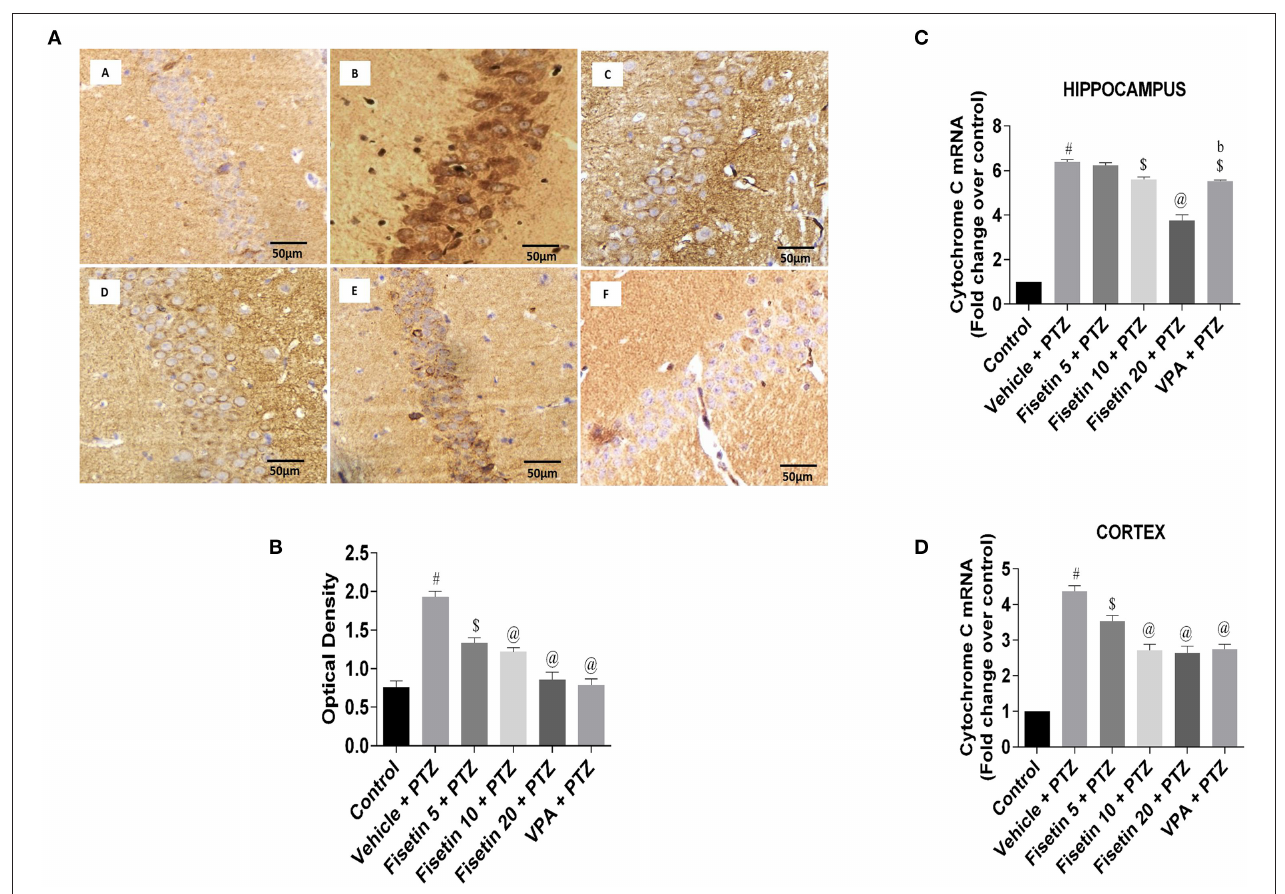
FIGURE 8 | Effect of fisetin administration on apoptosis marker, cytochrome C in kindled mice. (A) Photomicrographs of the hippocampus in different experimental groups are shown (40X). (A) Control, (B) vehicle + PTZ, (C) fisetin 5 + PTZ, (D) fisetin 10 + PTZ, (E) fisetin 20 + PTZ, and (F) VPA + PTZ. Fisetin administration resulted in reduced immunoreactivity of cytochrome C protein in pyramidal cells of the hippocampus compared with the vehicle + PTZ group. (B) Quantitative estimation of cytochrome C immunostaining ( n = 3). (C) mRNA expression of cytochrome C in the hippocampus ( n = 5). (D) mRNA expression of cytochrome C in the cortex ( n = 5). Data were analyzed by one-way ANOVA followed by Tukey’s multiple comparison test and expressed as mean ± SEM. # p < 0.001 as compared with control group; $ p < 0.01 as compared with vehicle + PTZ group; @ p < 0.001 as compared with vehicle + PTZ group, and b p < 0.001 as compared with fisetin 20 + PTZ